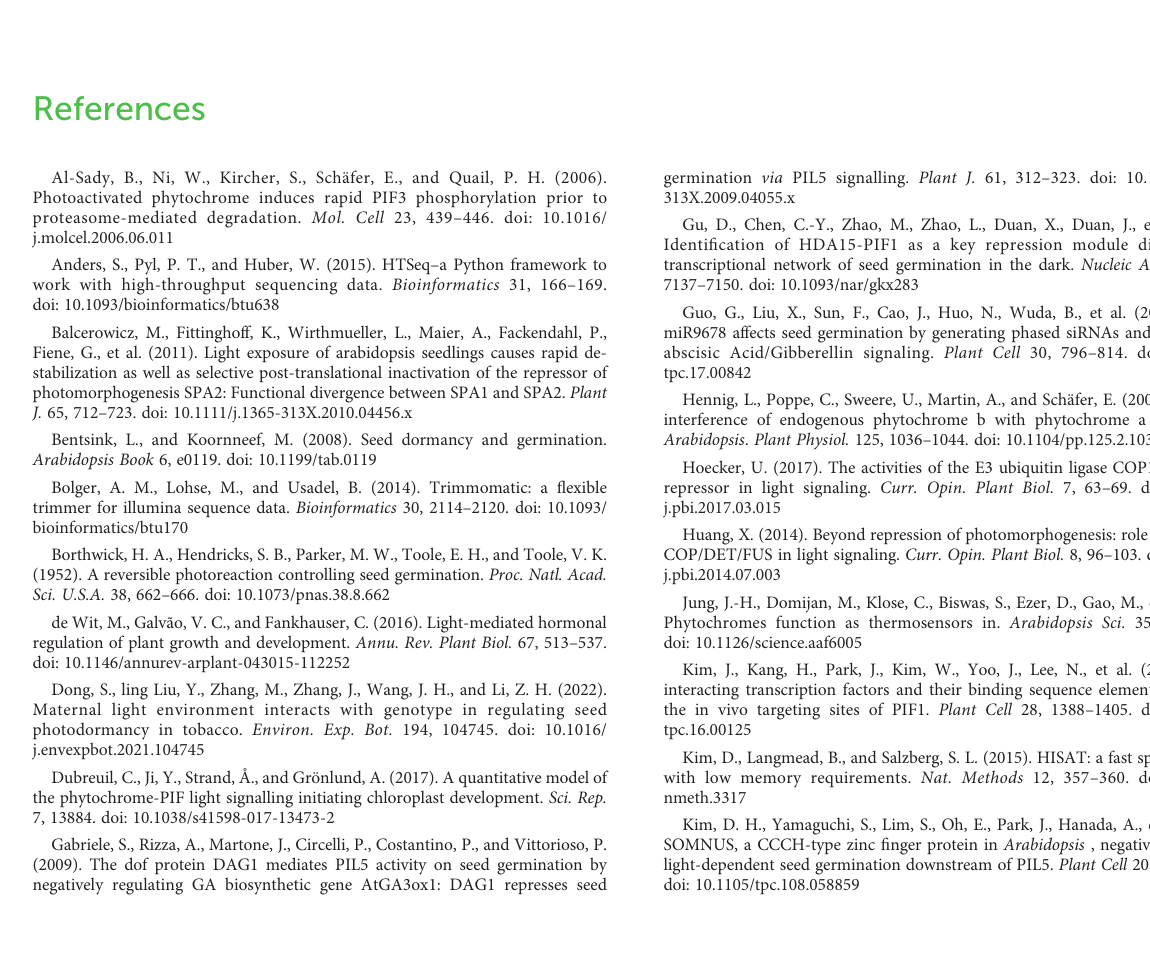
SUPPLEMENTARY FIGURE 5 Multiple comparisons of light-regulated DEGs (DEPs) during seed germination and post-germination development. The histogram on the left represents the number of co-up and co-down regulated DEGs (DEPs) withineachcomparison.Thehistogramonthetoprepresentsthenumber of co-up or -down regulated DEGs (DEPs) from multiple comparisons. Multiple comparisons are displayed by lines and linked dots.